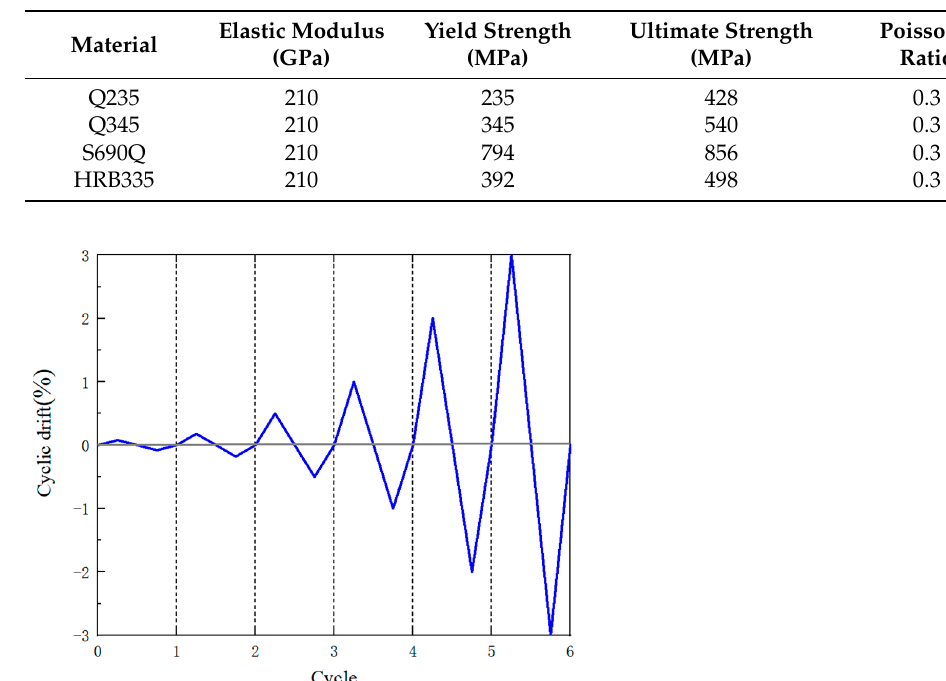
Figure 8. Loading protocol.